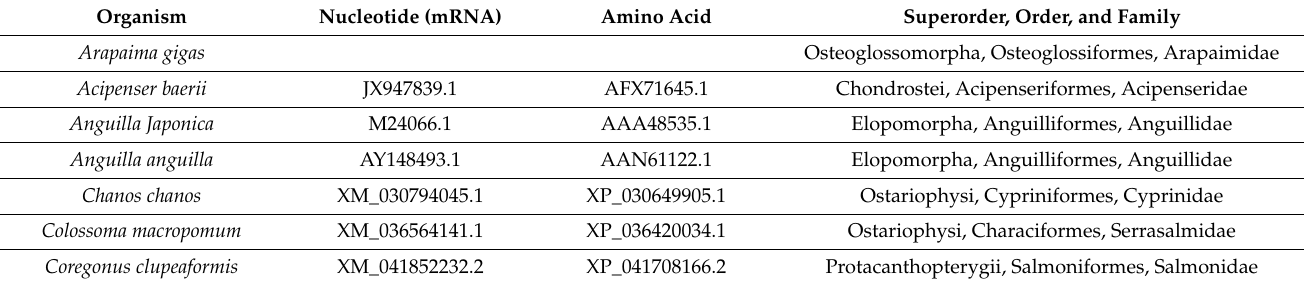
Table 2. Fish species and GenBank accession numbers of the sequences used in the amino acid percentage determinations and cDNA cloning of the fish growth